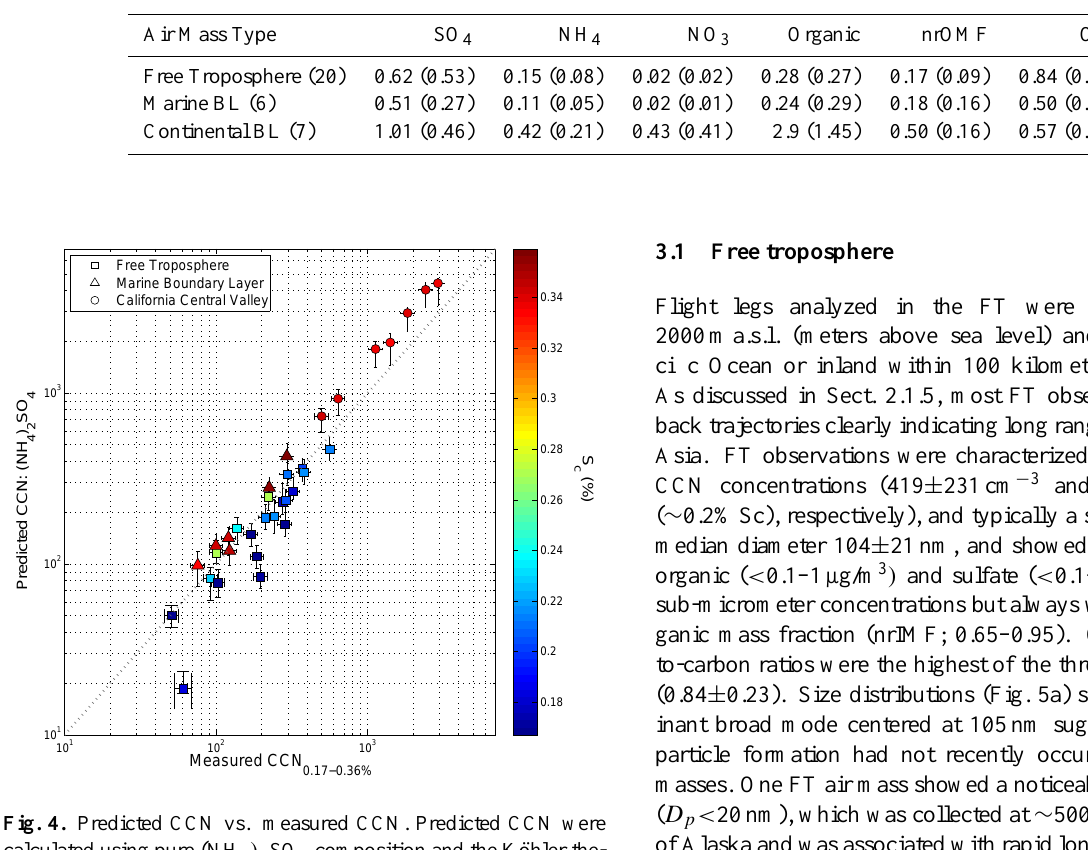
Table 4. Bulk submicron mass concentrations (µg m − 3 ) , non-refractory organic mass fractions (nrOMF), and oxygen-to-carbon ratios (O/C) measured by HR-ToF-AMS for air mass categories. Standard deviations are shown in parentheses. The number of flight legs analyzed for each air mass category is shown in parenthesis in the first column.